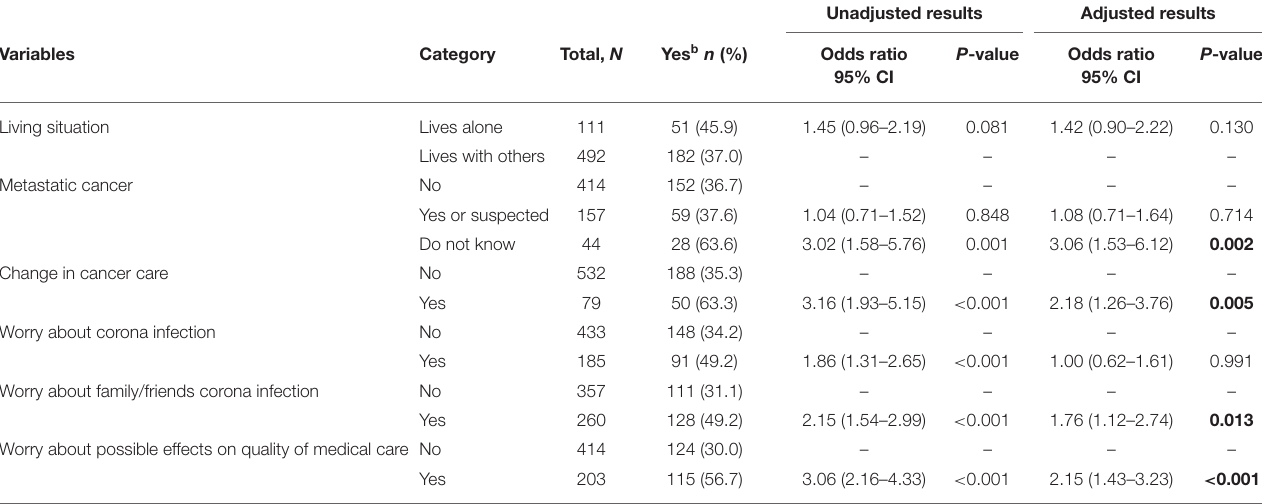
TABLE 8 | Logistic regression of associated factors for symptoms of depression a